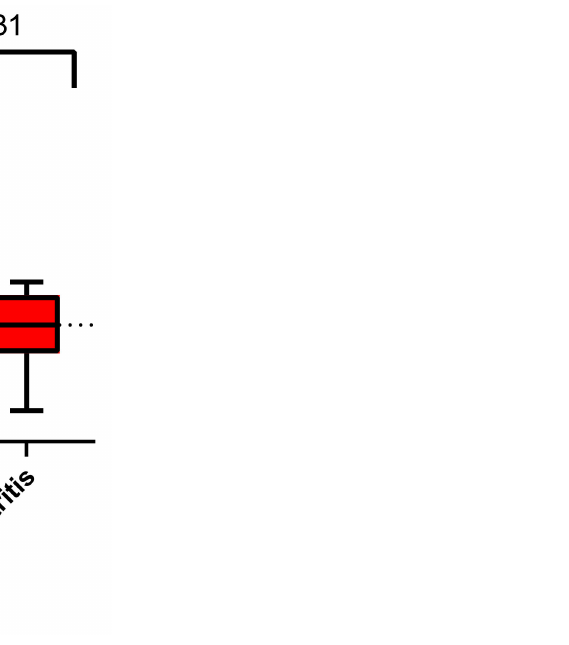
Figure 5. Log 2 (2 − ∆ Ct ) miR-155 comparison between patients with acute and chronic